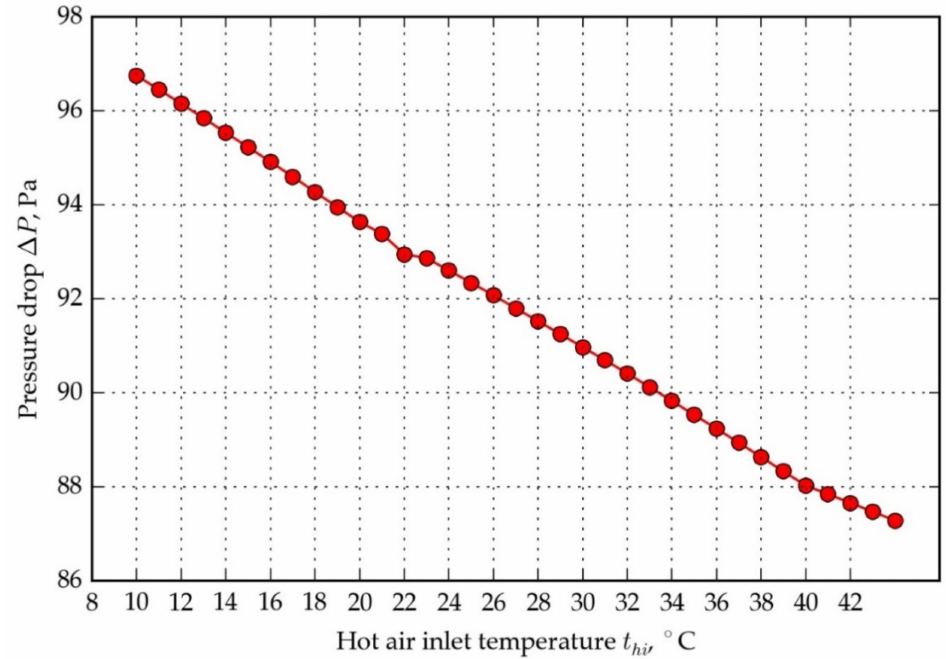
Figure 12. Pressure drop vs. hot air inlet temperature, for cold stream inlet temperature 0 ◦ C and 20 HPs